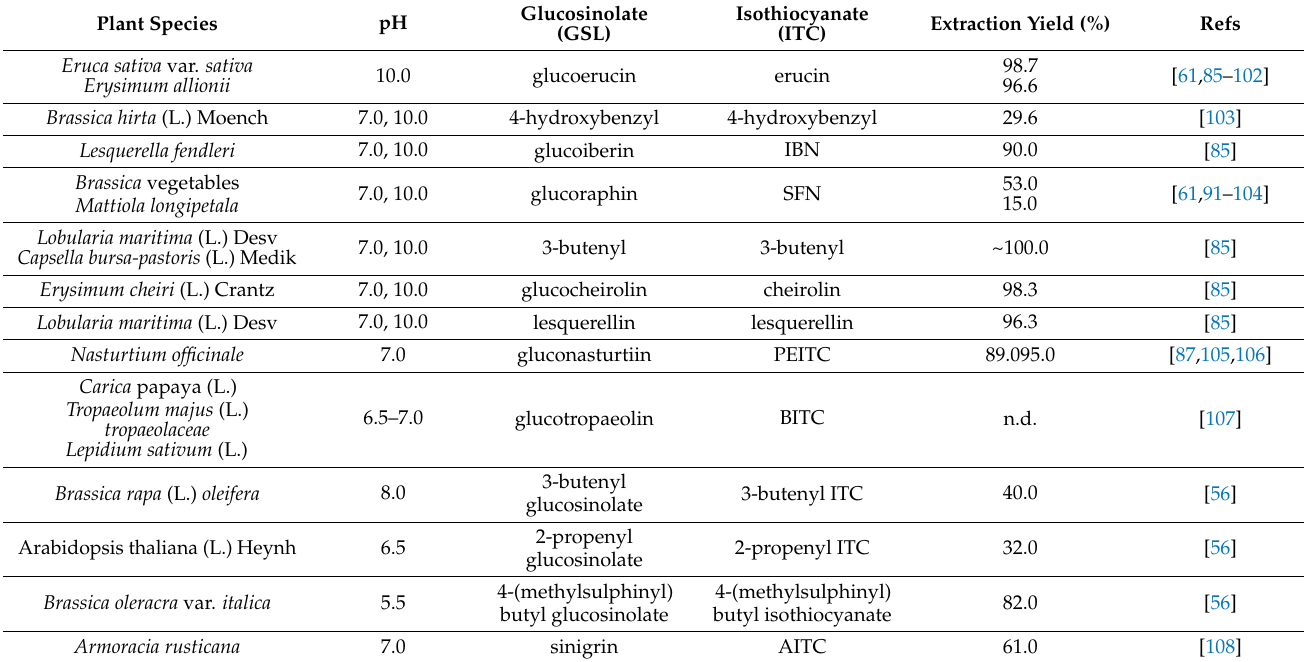
Table 2. Optimum pH conditions for complete conversion of various GSLs into their respective ITCs in various